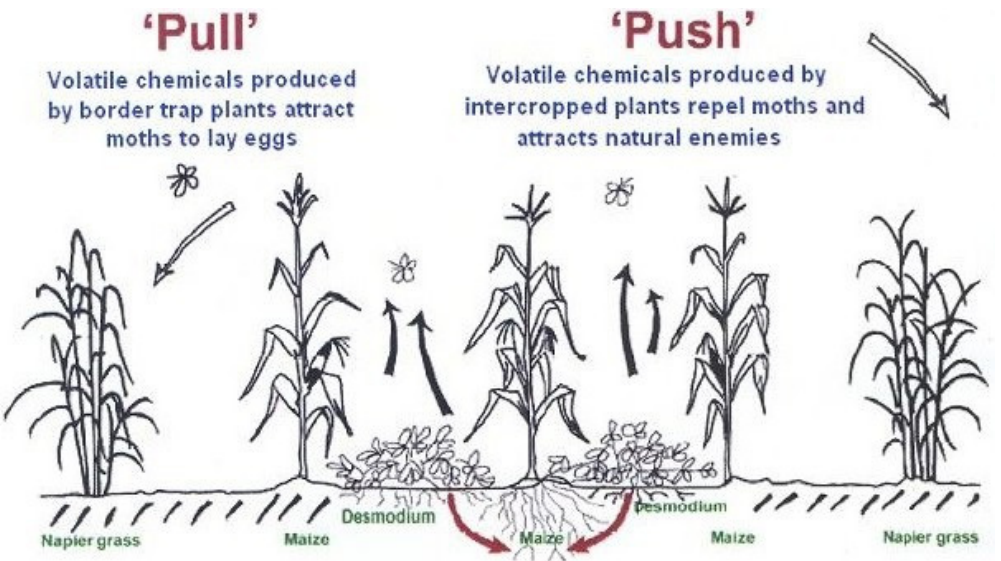
Figure 2. Schematic representation of “push ‐ pull” cropping system (source: www . push ‐ pull.net ) [46].